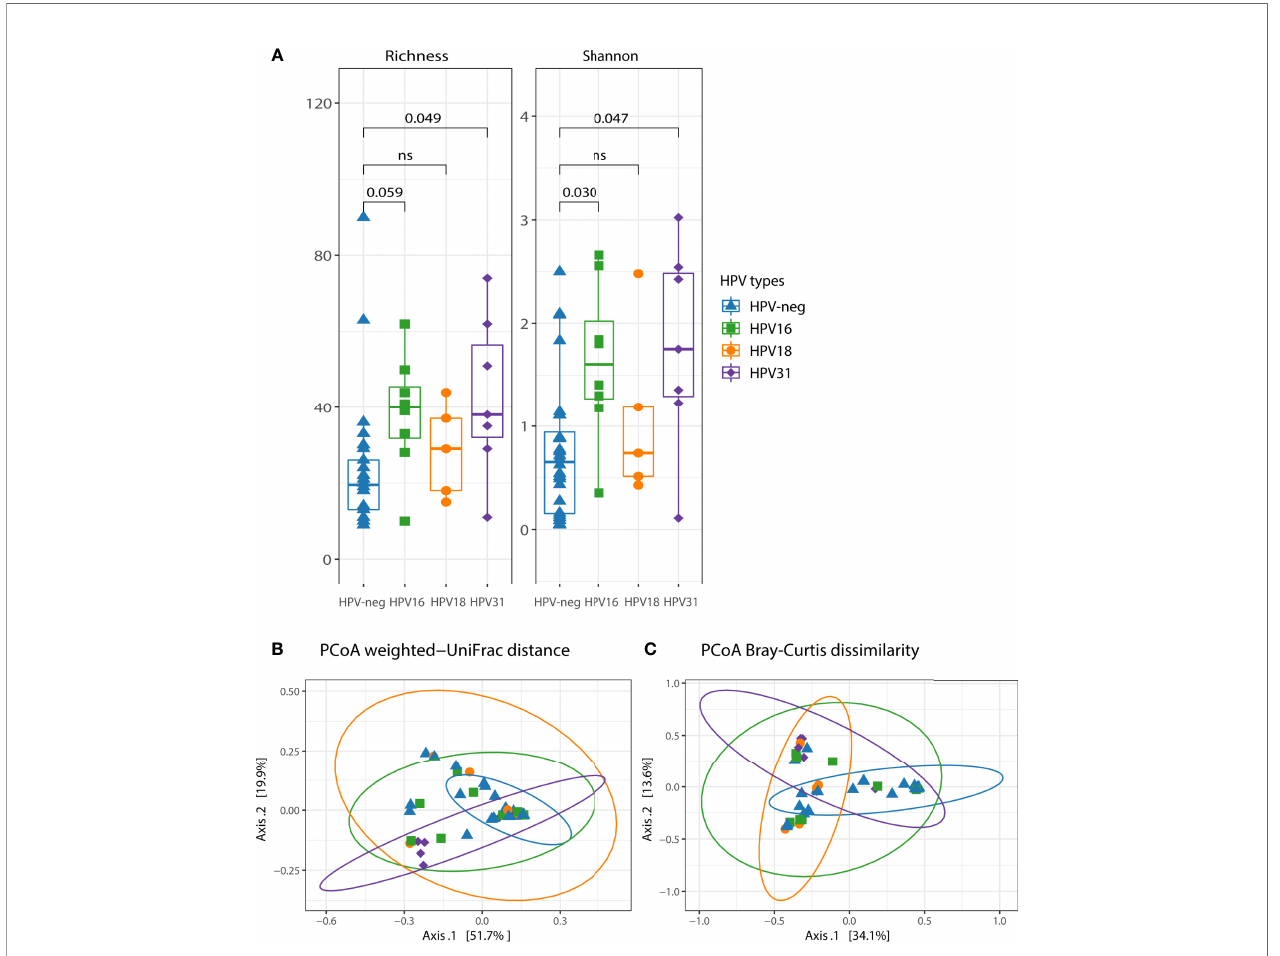
FIGURE 3 | The impact of single HPV16, HPV31 and HPV18 on the vaginal microbiota diversity and community membership. (A) Two alpha diversity indexes were calculated, richness (observed species) and shannon. Boxplots depicting the median and interquartile range strati fi ed by single HPV infection. Groups were compared using the Kruskal-Wallis test, p values were adjusted for multiple comparisons. Both weighted UniFrac (B) and Bray-Curtis dissimilarity (C) were used in conjunction with principal coordinate analysis (PCoA) to visualize microbial communities strati fi ed by single HPV infection. Differences in beta diversity were assessed using permutational multivariate analysis of variance (PERMANOVA). Each point was colored according to the single HPV type. Con fi dence ellipses are shown for each